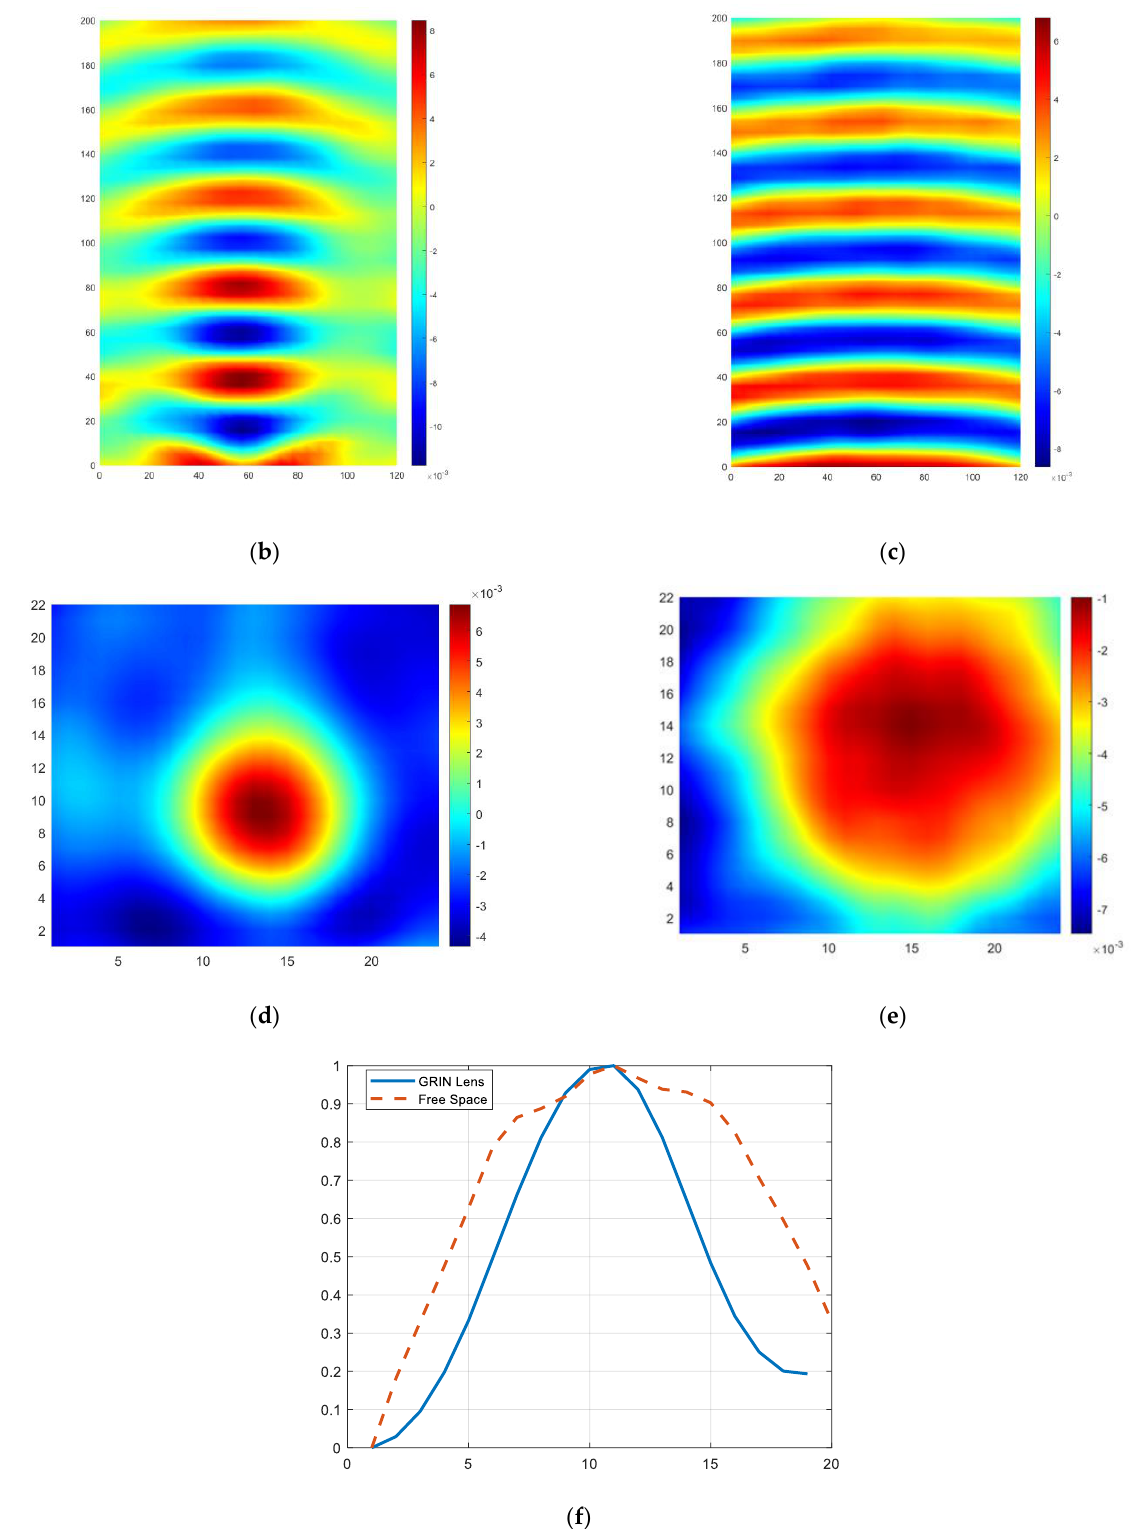
Figure 10. ( a ) Fabricated 2D GRIN Metasurface Lens. ( b ) Field distribution in horizontal plane with lens and ( c ) without lens. ( d ) Field distribution in vertical (focal) plane with lens and ( e ) without lens. ( f ) Cross- range intensity profile comparison of lens and free space at focal plane.